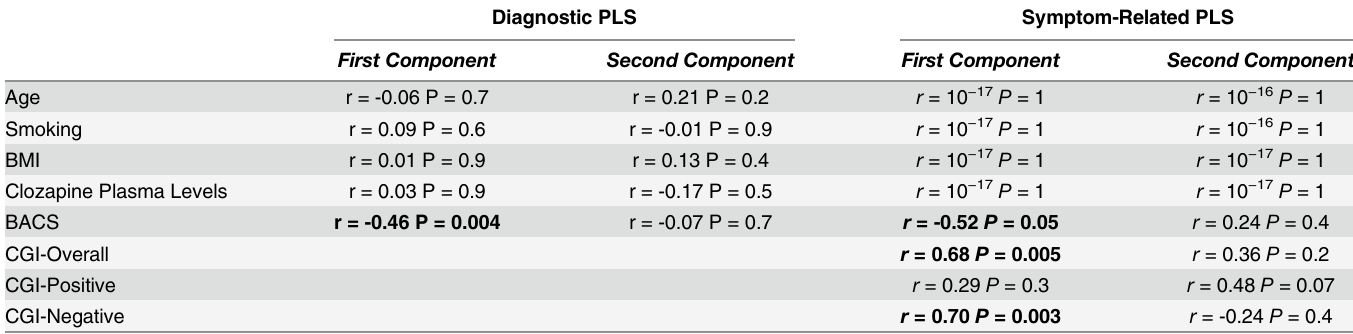
Table 1. First two PLS component scores for diagnostic and for cognitive and psychotic symptom-related PLS analyses. In both cases, PLS com- ponent scores were significantly correlated with cognitive (BACS) or symptom (CGI) scores, but not with confounds (age, smoking, BMI). Diagnostic PLS Symptom-Related